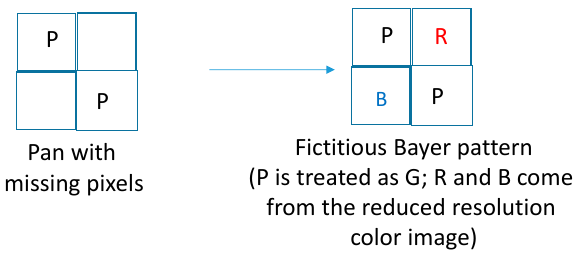
Figure 6. Fictitious Bayer pattern for pan band generation.